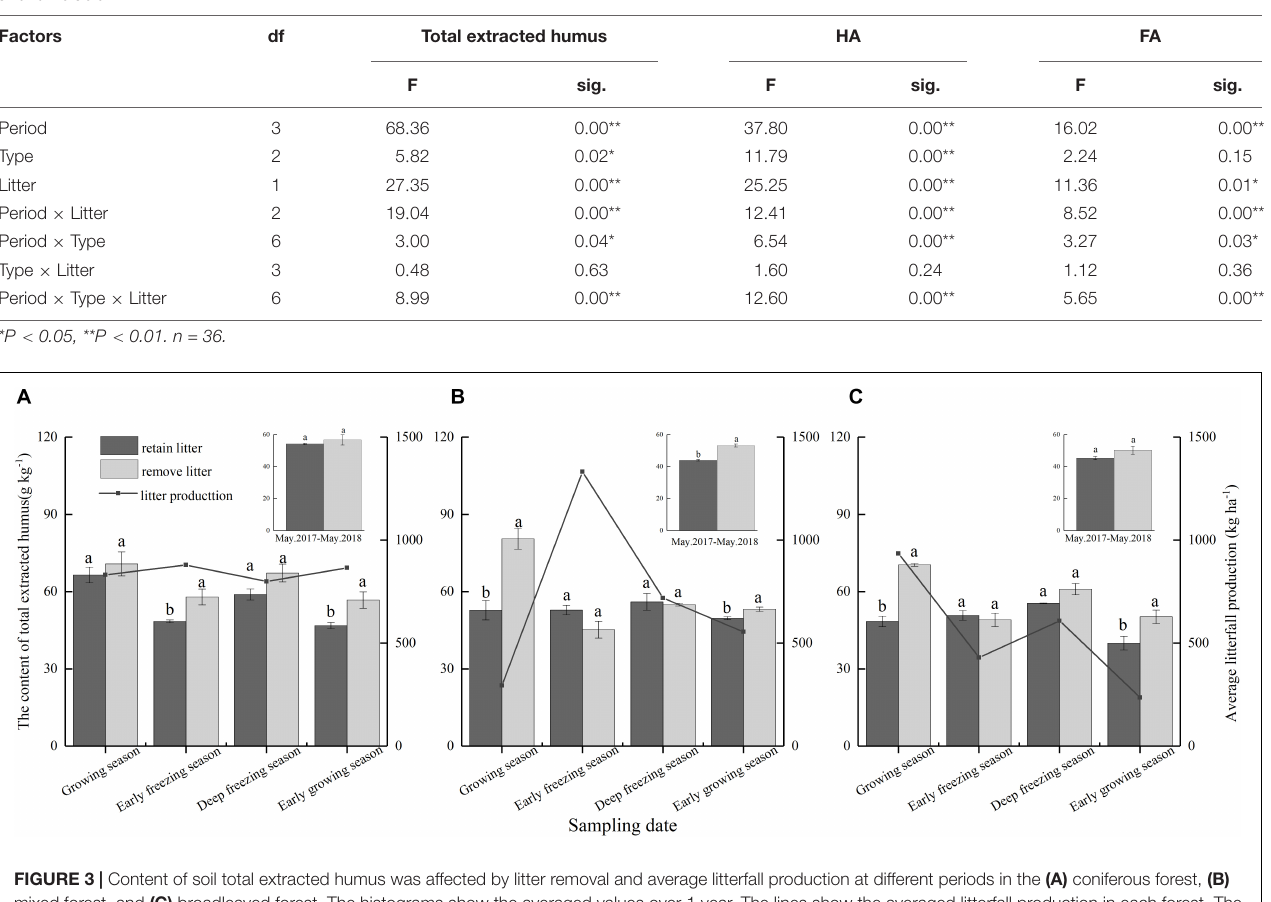
FIGURE 3 | Content of soil total extracted humus was affected by litter removal and average litterfall production at different periods in the (A) coniferous forest, (B) mixed forest, and (C) broadleaved forest. The histograms show the averaged values over 1 year. The lines show the averaged litterfall production in each forest. The presented content values are the means of 3 observations; the error bars represent standard errors. Lowercase letters represent significant differences in the contents of total extracted humus between the different litterfall